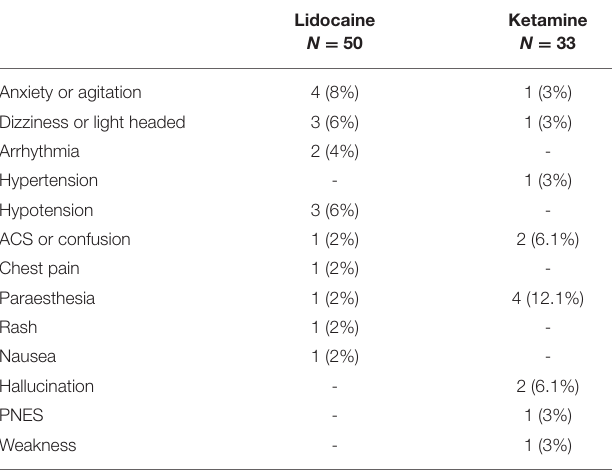
TABLE 2 | Side-effects of lidocaine and ketamine infusion.